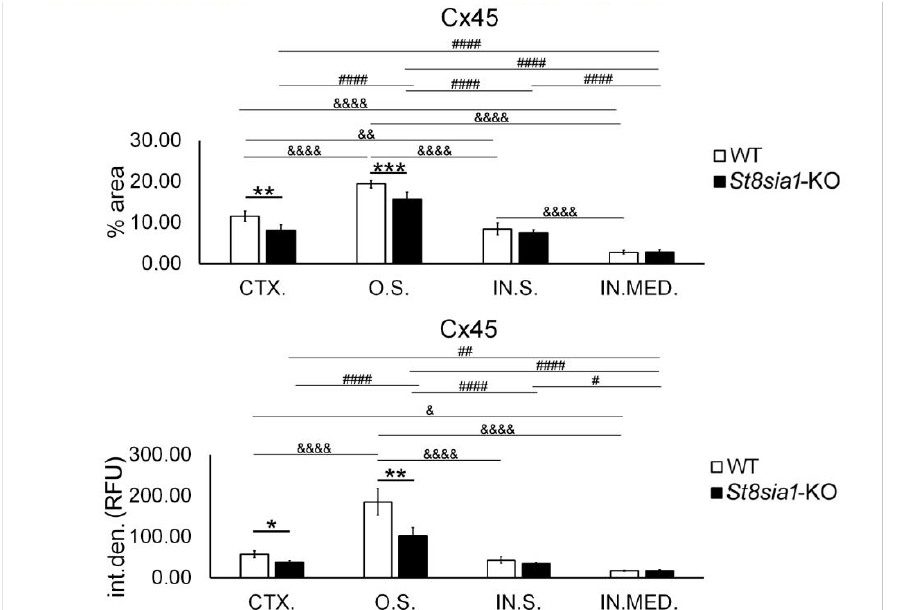
Figure 7. Expression of connexin 45 in different renal parts of the wild type and St8sia1 -KO mice. WT—wild-type mice; St8sia1 -KO— St8sia1 knockout mice; CTX.—Cortex; O.S.—outer stripe of outer medulla; IN.S.—inner stripe of outer medulla; IN.MED.—inner medulla; % area—percentage of the section area occupied by Cx45 immunofluorescence; int.den. (RFU)—integrated density (relative fluorescence units). Column a—representative photomicrographs of the indicated kidney section areas stained with Cx45 (green) and alpha-smooth-actin (red) antibodies; nuclei are stained blue. Column b—(same section as in a) processed and thresholded photomicrographs prepared for analysis (inverted black for white on thresholded green image). Statistically significant difference between WT and St8sia1 -KO: * p < 0.05; ** p < 0.01; *** p < 0.001 ( t -test for unequal variances). Comparison between different kidney areas in the same group of mice WT: & p < 0.05, && p < 0.01, &&&& p < 0.0001; or St8Sia1 -#— p < 0.05. ## p < 0.01, #### p < 0.0001 (one-way ANOVA followed by Tukey’s test for dependent samples). Scale-bar = 20 µ m, refers to all (magnification 400 ×